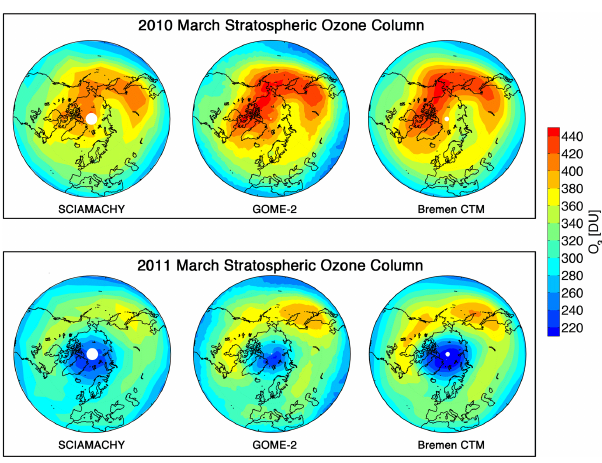
Fig. 4. Mean stratospheric columns of ozone in March 2010 (top) and 2011 (bottom) as obtained from SCIAMACHY in limb-viewing geometry (left), the nadir-viewing scanning spectrometer GOME-2 and as inferred from chemistry transport model calculations (right). For GOME-2 the stratospheric column was obtained by subtracting tropospheric ozone (climatological values) from the measured total